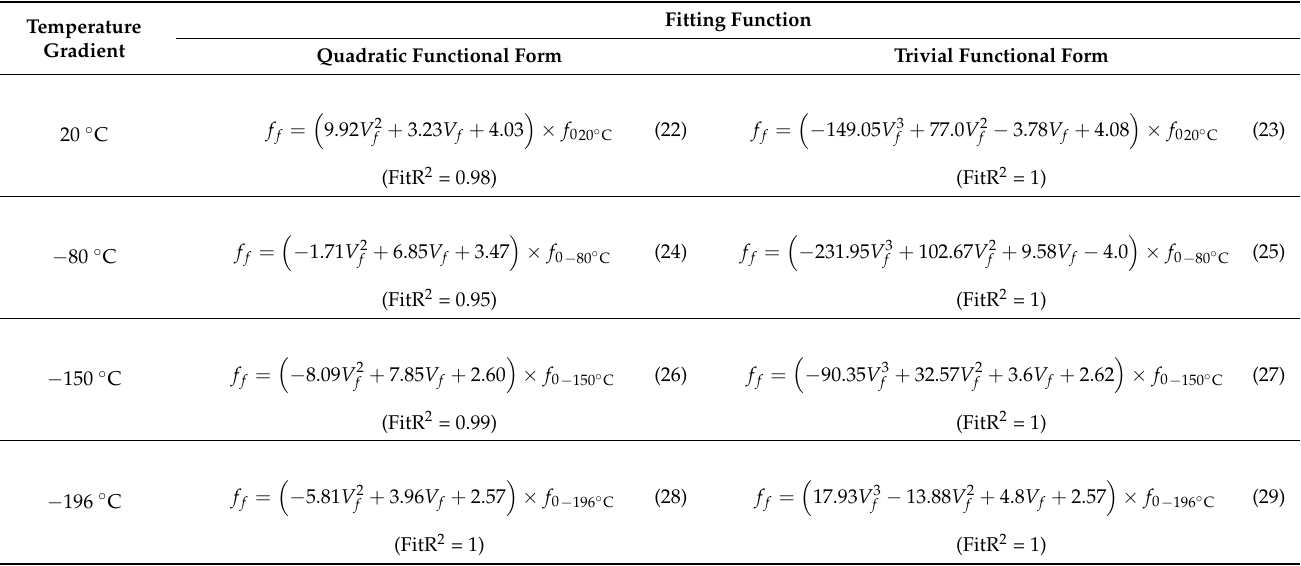
Table 7. Fitting function of flexural strength with different fiber volume fractions and different temperature